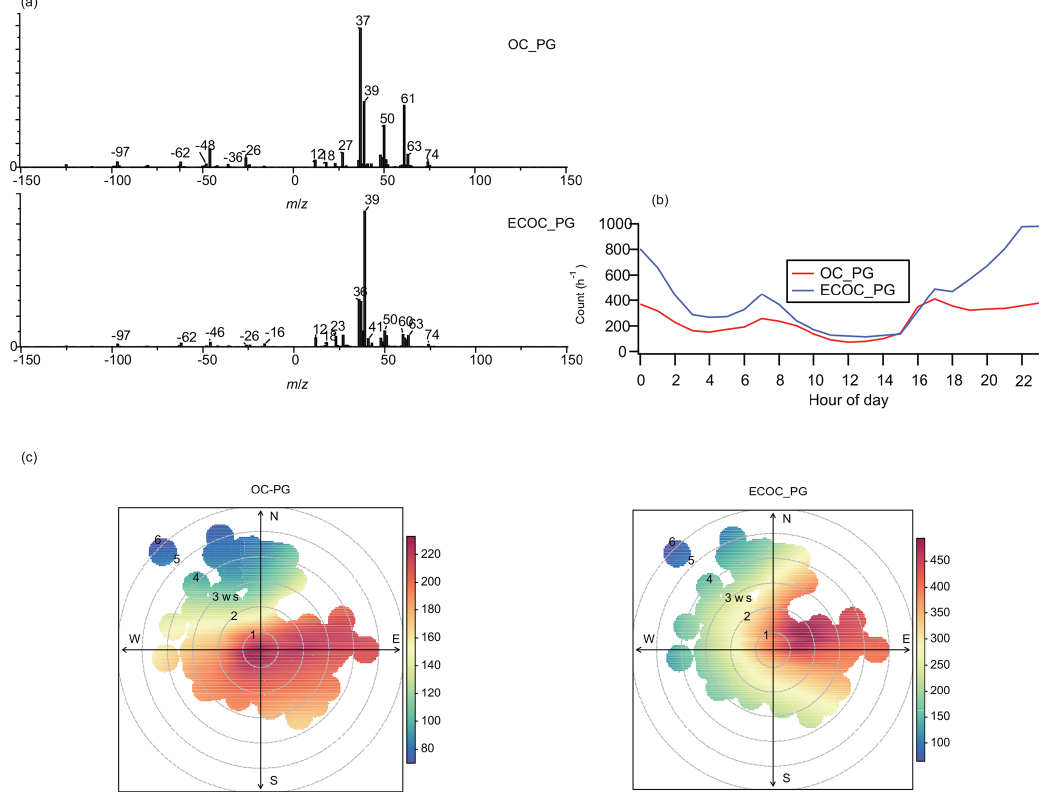
Figure 10. (a) Average mass spectra of OC_PG and ECOC_PG, (b) diurnal plots of OC_PG and ECOC_PG, and (c) polar plots of OC_PG and ECOC_PG. All these particle types appeared at the PG